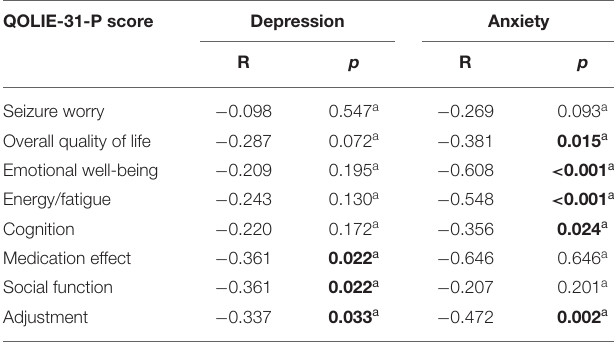
TABLE 3 | Correlation between QOLIE-31 scores and depression and anxiety after surgery. QOLIE-31-P